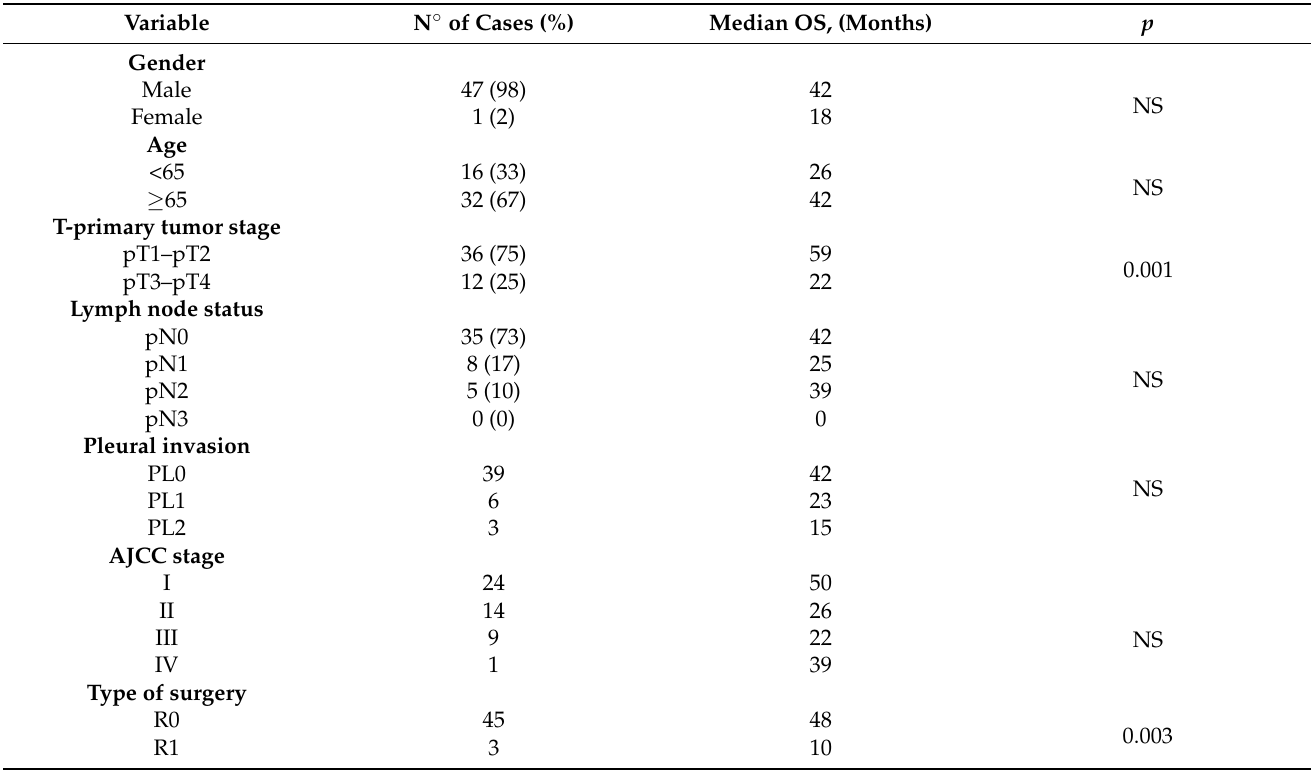
Table 1. Prognostic impact of clinic-pathological characteristics on overall survival (OS) in 48 patients with pulmonary squamous cell carcinoma